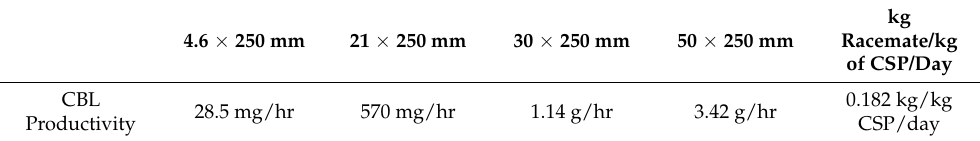
Table 9. Productivity of CBL separation on various column dimensions.